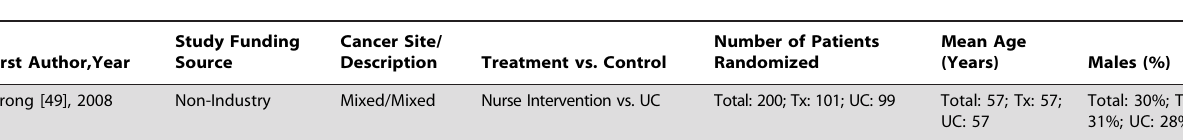
Table 4. Characteristics of Randomized Controlled Trial of Depression